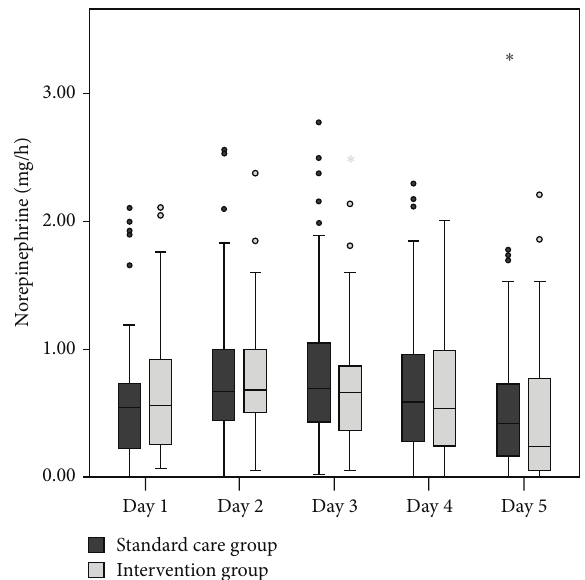
Figure 2: Box plot depicting the mean daily dose of norepinephrine in each of both groups. There was also no significant difference between the two